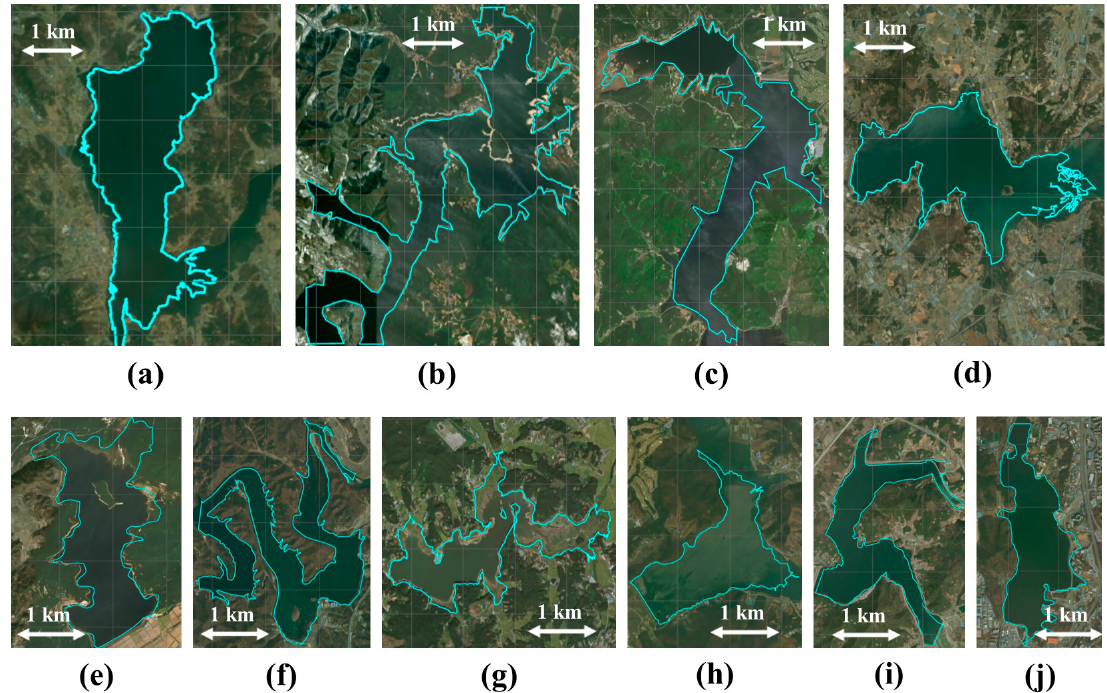
Figure 10. Boundary data and satellite images of top 10 reservoirs with the highest power production: ( a ) Yedang; ( b ) Seomjin; ( c ) Najuho; ( d ) Topjeong; ( e ) Togyo; ( f ) Miho; ( g ) Gosam; ( h )Bulgop; ( i ) Yidong; ( j ) Deokdong. Table 4. The analysis results of the top 10 reservoirs with the highest power production and with the highest efficiency.